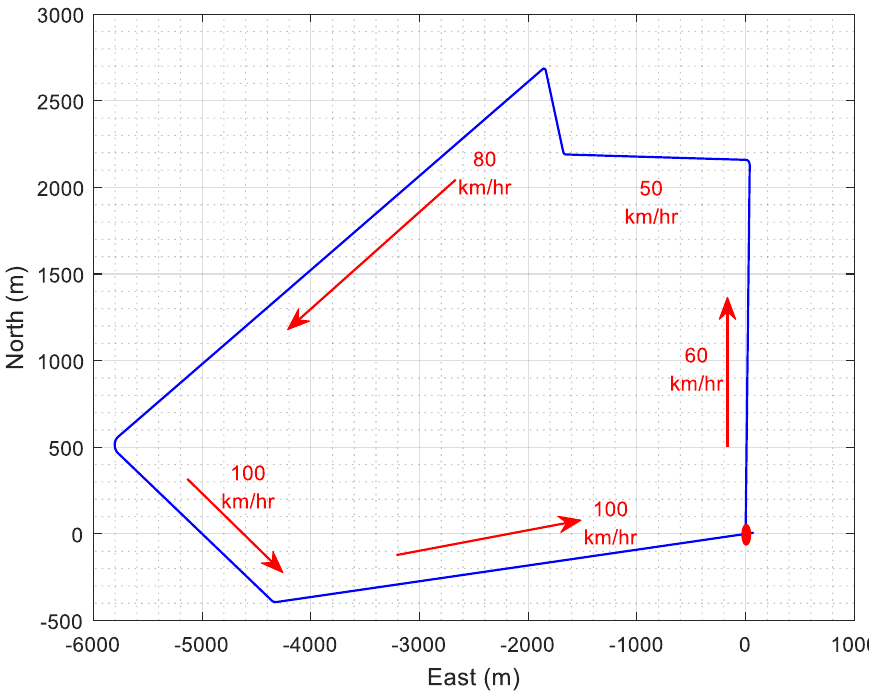
Figure 3. The full experiment trajectory.